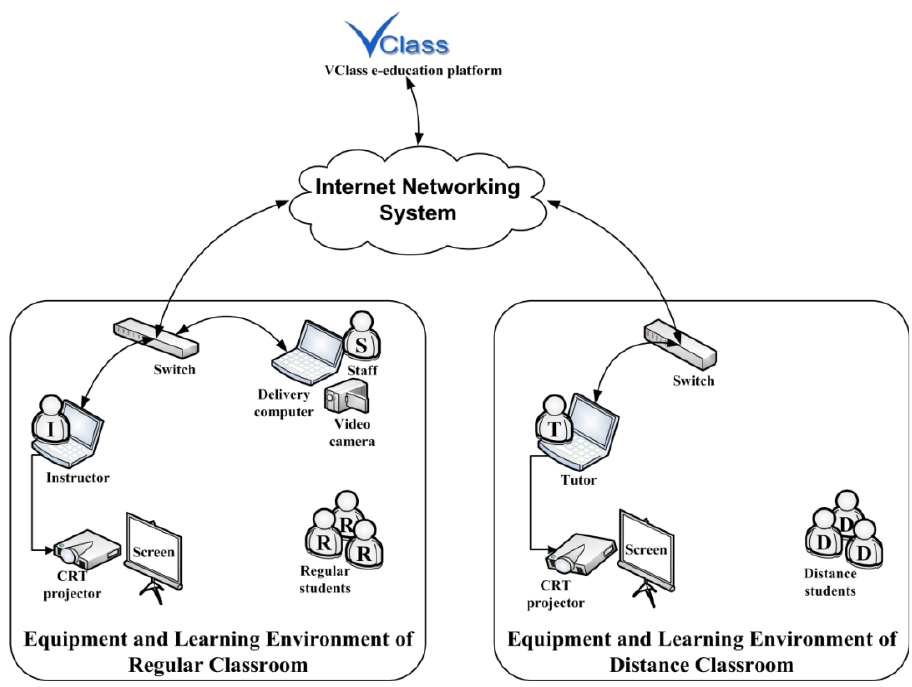
Figure 1. Learning environment for IBDL through